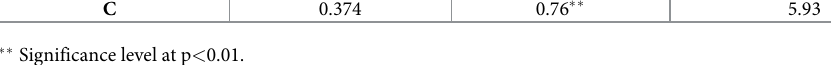
�� Significance level at p <